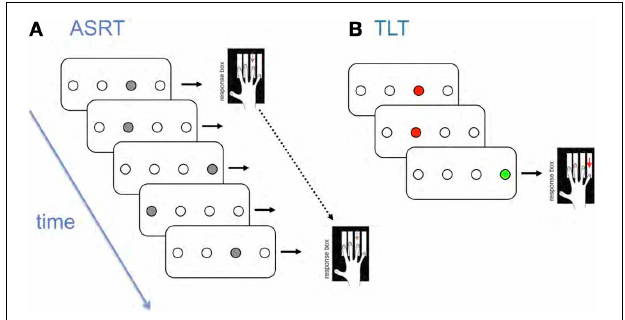
FIGURE 1 | Schematic representation of (A) the Alternating Serial Reaction Time Task (ASRT) and (B) The Triplets Learning Task (TLT).